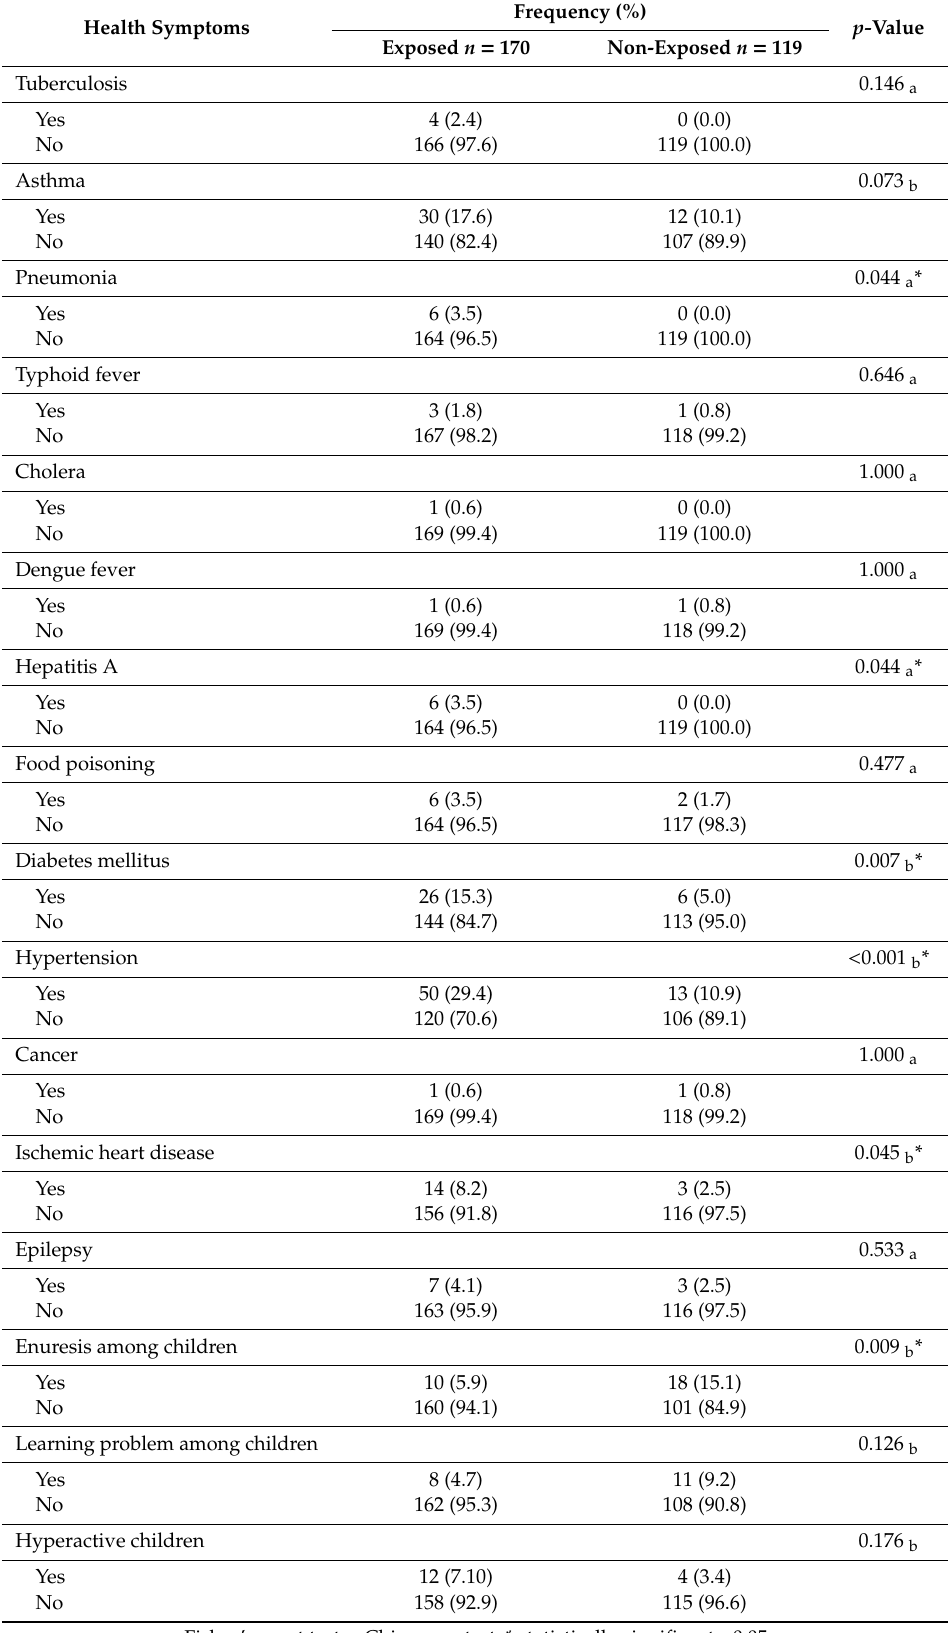
Table 4. Comparison of prevalence of diseases among family members between the exposed and unexposed groups to the solid waste dumpsite in